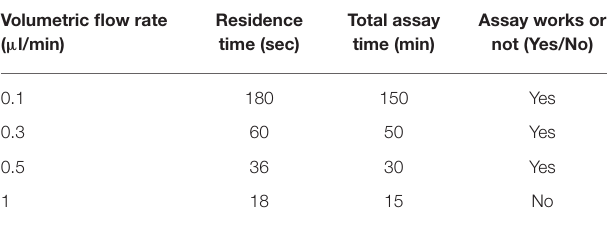
TABLE 2 | Residence time, time to complete assay, and working outcomes of bioassay under different flow